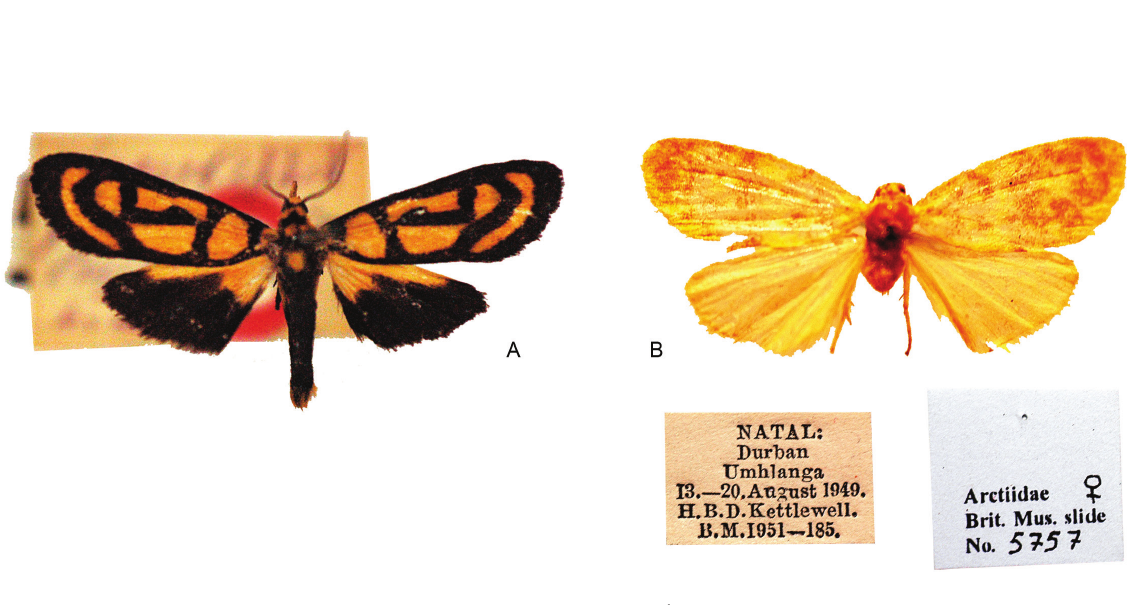
Fig. 4. — A . Xanthetis luzonica (Felder, 1875), holotype ♂, Philippines, in BMNH. — B . Afrasura ichorina (Butler, 1877), ♀, South Africa, in